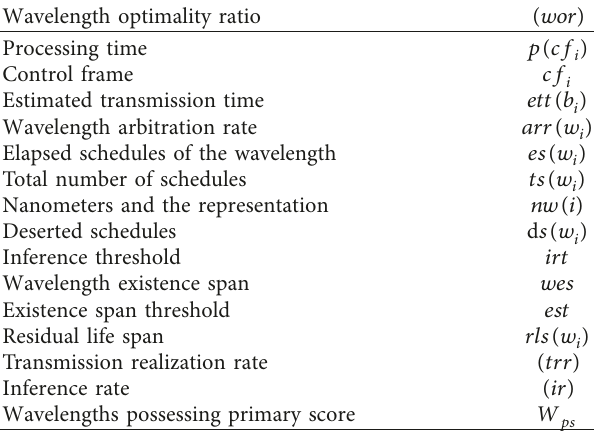
Table 1: Notations for